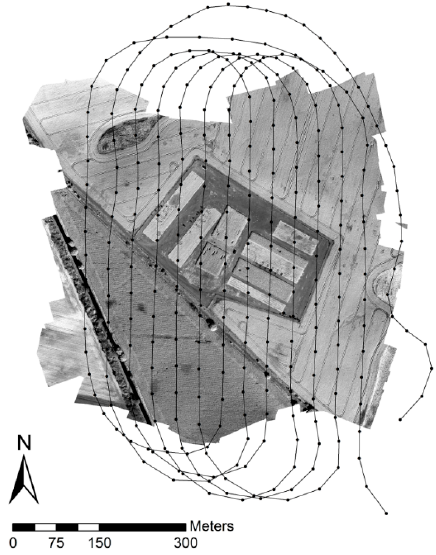
Figure 9. Image mosaic of b 761 . Overlay: Reconstructed flight path from recorded GPS locations (black dots).